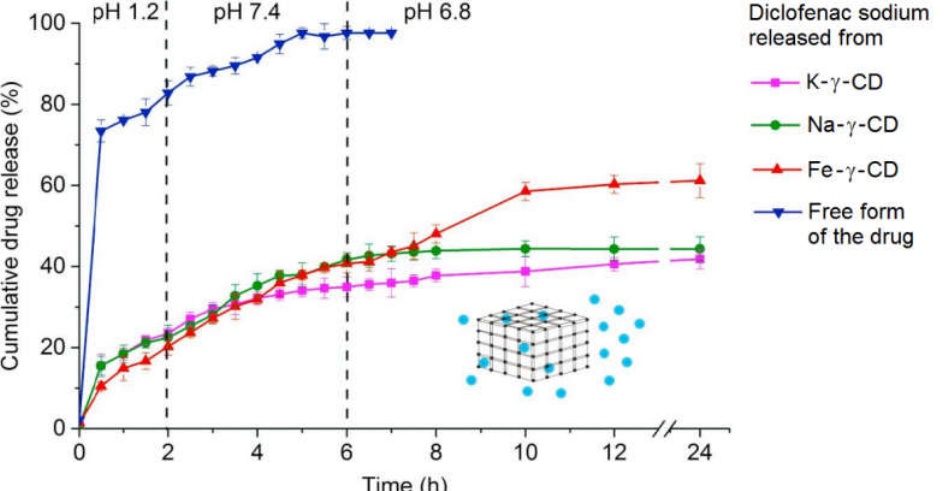
Figure 3. Release rates of diclofenac sodium, either in the free form (blue triangles) or when carried by K- γ -CD-MOF (pink squares), Na- γ -CD-MOF (green dots) and Fe- γ -CD-MOF (red triangles) in different simulated biological fluids: HCl 0.2 M (pH 1.2) to simulate the gastric fluid, phosphate buffer solution (PBS) at pH 7.4 to simulate the intestinal fluid and PBS at pH 6.8 to simulate the colonic fluid. Reproduced with permission from Abuçafy et al . [38].